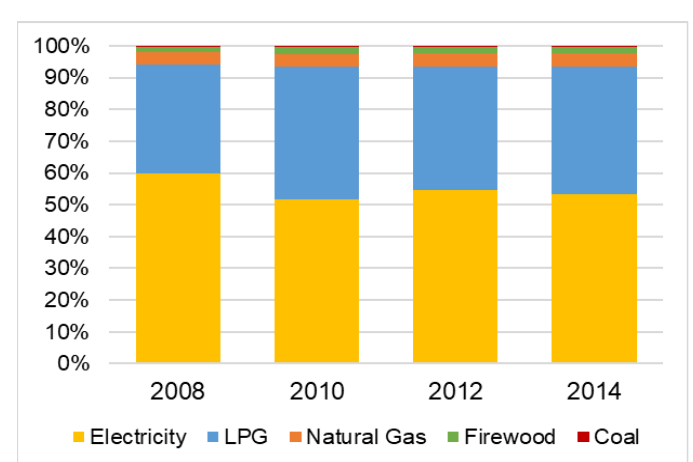
Fig. 1. Household energy consumption by energy goods, 2008–2014 (INEGI, 2015a).